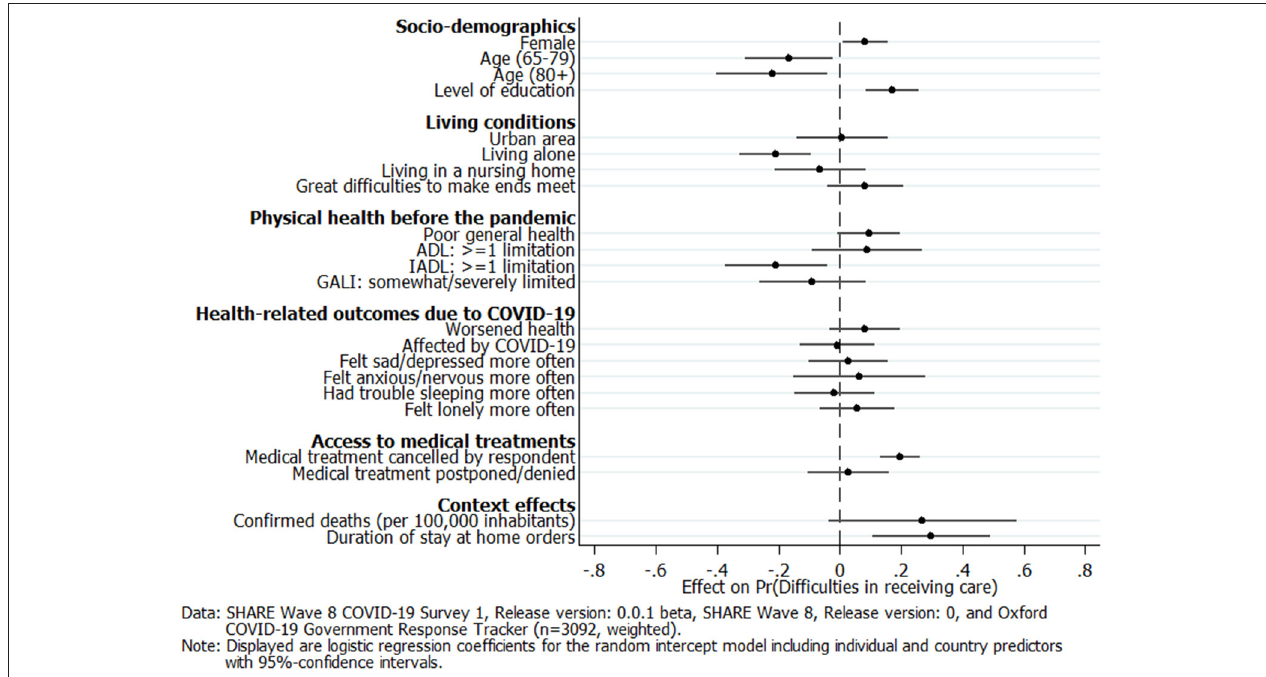
FIGURE 7 | Multilevel logistic regression coefficients of respondent and country predictors on perceived difficulties in receiving care.